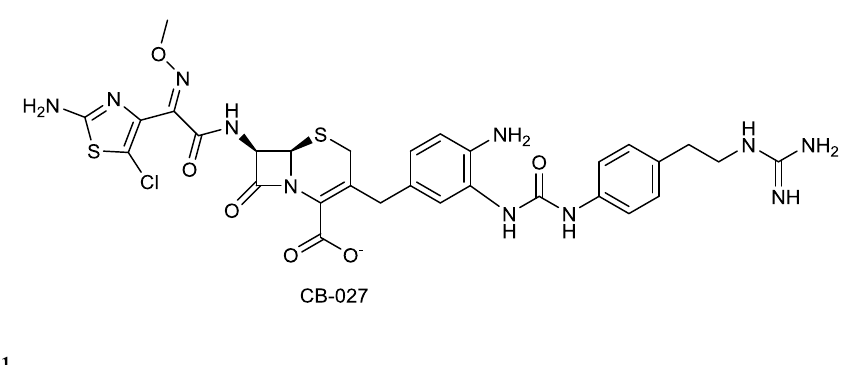
Figure 21. Chemical structure of CB-027.